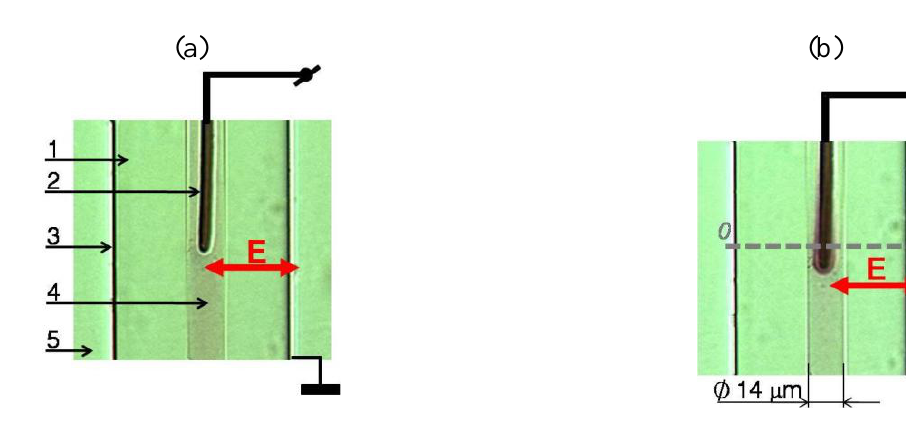
Figure 11. The cylindrical cell formed by a glass capillary (1), a copper wire electrode along the capillary axis (2), and a transparent electrode at the outer surface (3). The cavity is filled with “long/thin” NRs in toluene (4) and sealed by polymerized optical adhesive (5). Microscope textures (parallel polarizers) of the capillary when the field 𝐄 and on, 𝑈 = 170 𝑉 , 𝑓 = 100 kHz (b) . 𝑟𝑚𝑠